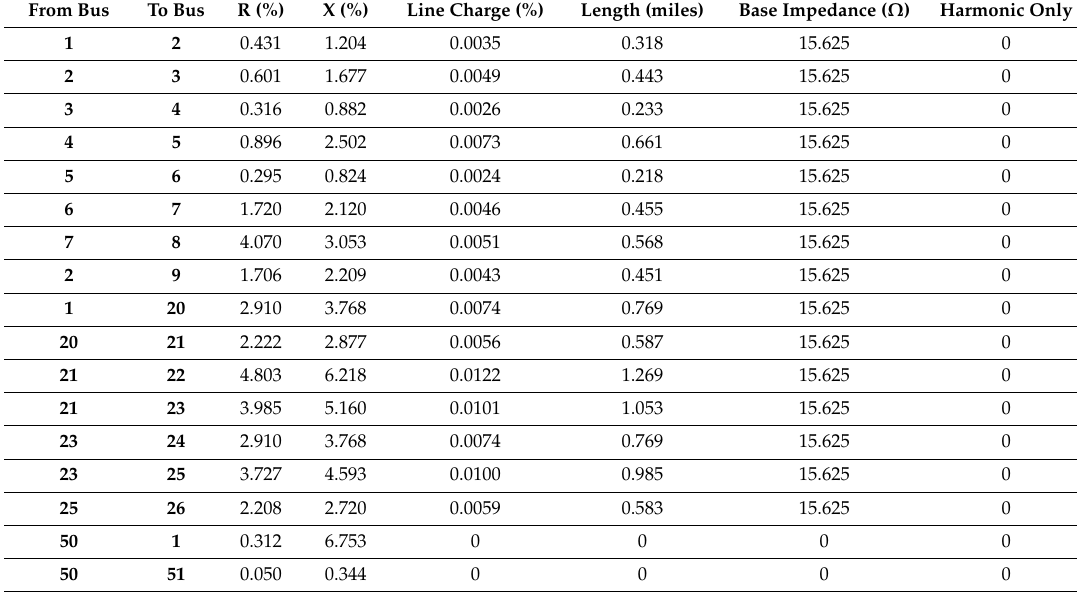
Table A1. The IEEE standard 18-bus system line information.